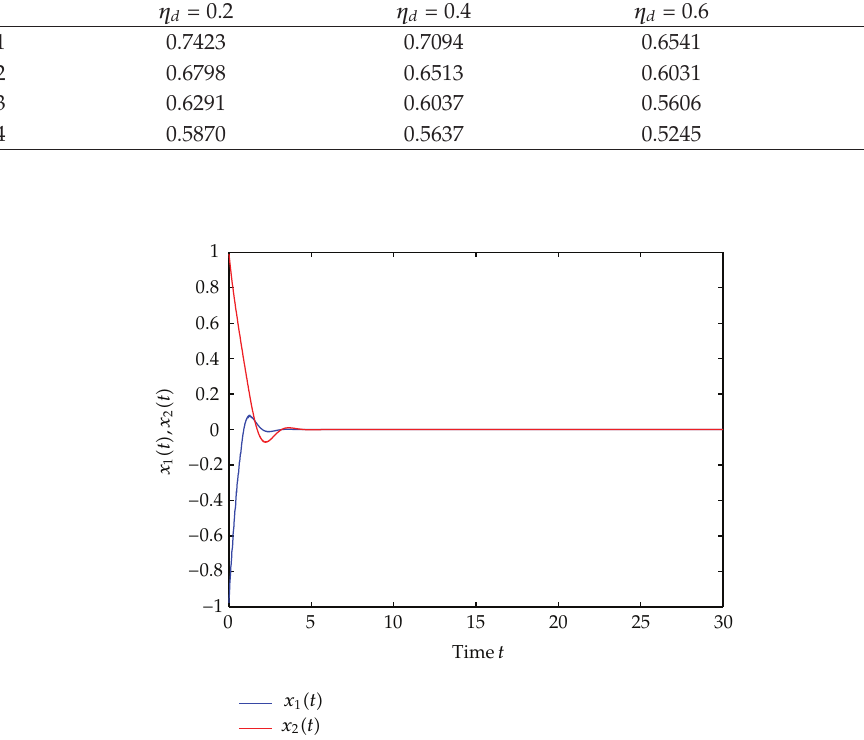
Figure 2: The trajectories of x 1 (cid:6) t (cid:7) and x 2 (cid:6) t (cid:7) of the uncertain Lur’e system with interval time-varying delay (cid:6) 4.3 (cid:7)